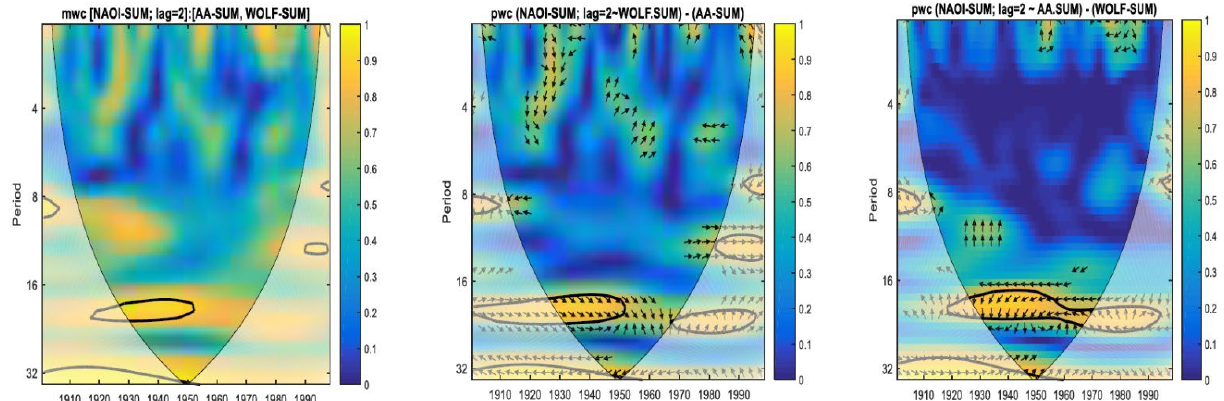
Figure 6. Mwc ( left panel ) between summer GBOI at lag = 2, and the two predictors aa (AA) and Wolf Number (WOLF); partial wavelet coherence ( pwc ) between GBOI and Wolf number, excluding the effect of aa ( middle panel ), and pwc between GBOI and aa , excluding the effect of Wolf number ( right panel ).